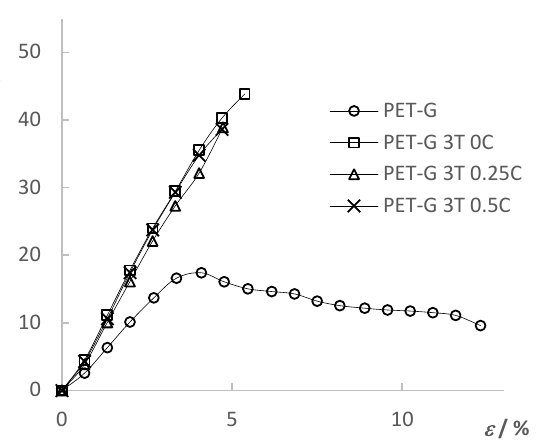
Figure 10. Tensile test results of PET-G and PET-G/3% TiO 2 composites with added CNT ratios .